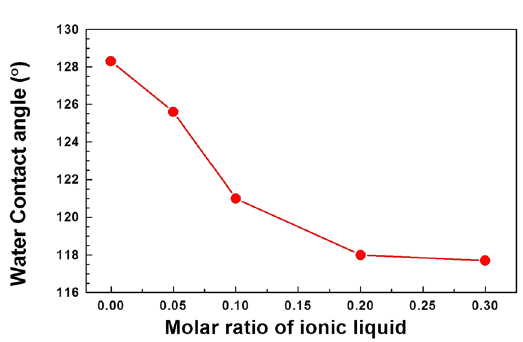
Figure 6. The water contact angles of the porous membranes PPHM-0 (0.0), PPHM-1 (0.05), PPHM-2 (0.1), PPHM-3 (0.2), and PPHM-4